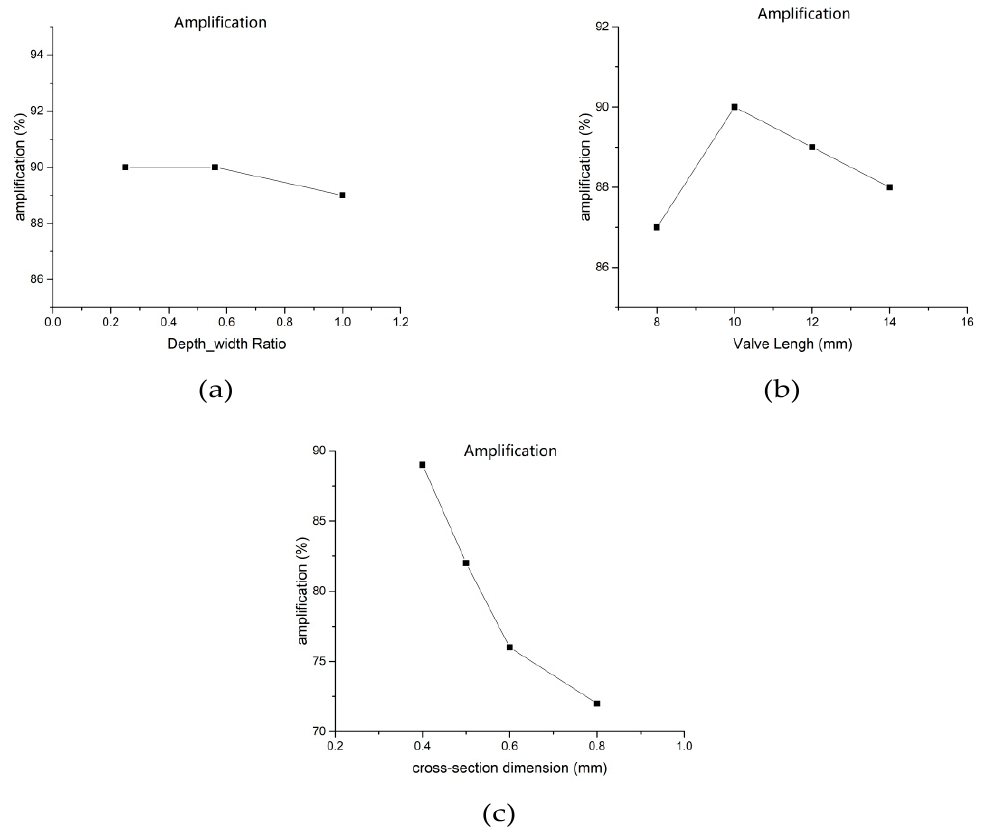
Figure 5. Effect of the microvalve geometry change on the outlet flow rate: ( a ) Depth-width Ratio ( b ) Valve length ( c ) Cross-section dimension.